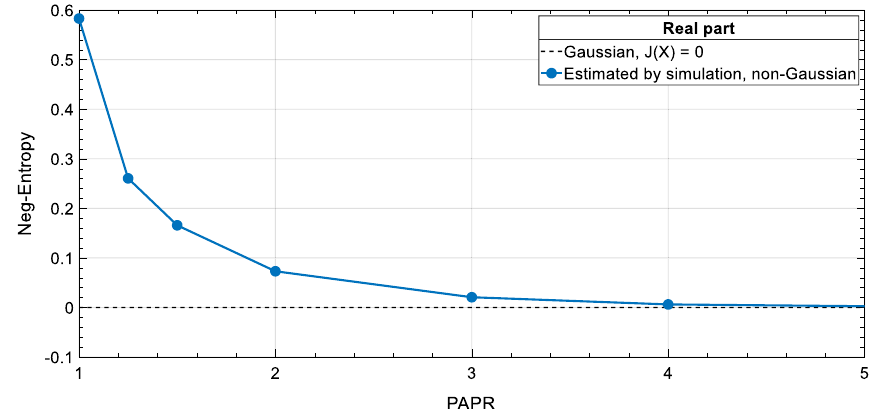
Fig. 12 Negentropy, Eq. (5), versus PAPR of the real part of a single noise waveform with unit power and uniform